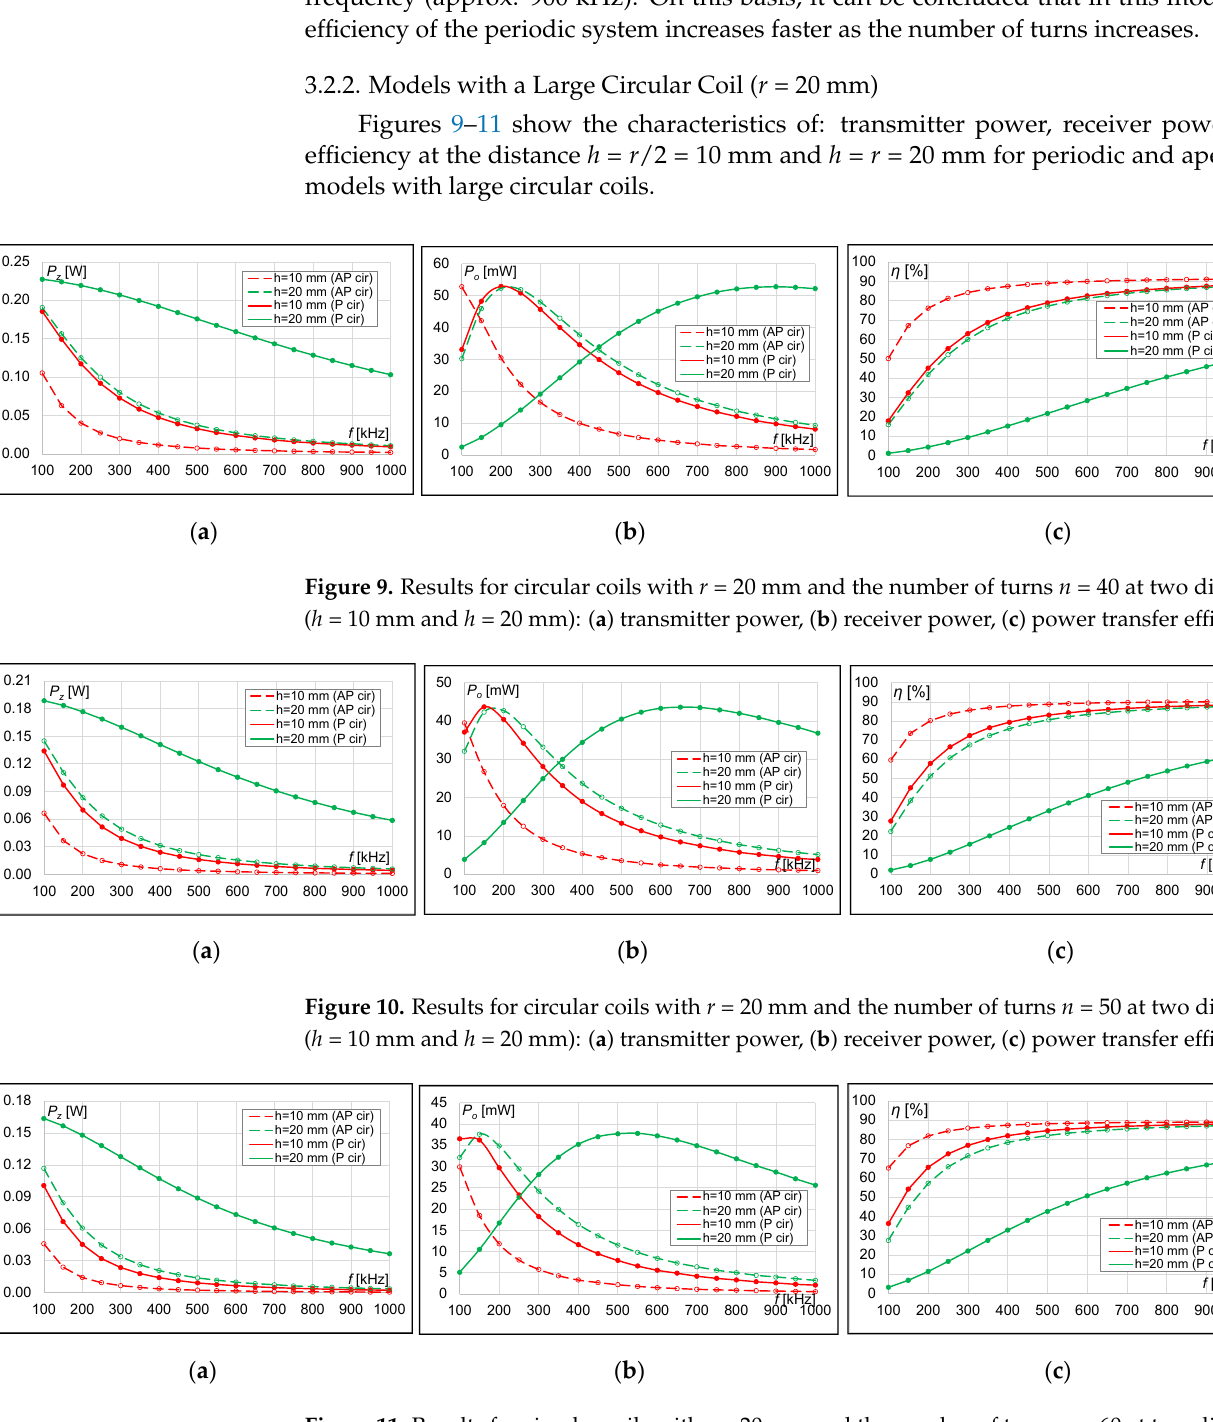
15 of 27 Figure 7. Results for circular coils with r = 5 mm and the number of turns n = 20 at two distances ( h = 2.5 mm and h = 5 mm): ( a ) transmitter power, ( b ) receiver power, ( c ) power transfer efficiency. ( a ) ( b ) ( c ) Figure 8. Results for circular coils with r = 5 mm and the number of turns n = 25 at two distances ( h = 2.5 mm and h = 5 mm): ( a ) transmitter power, ( b ) receiver power, ( c ) power transfer efficiency. In each of the analysed cases, the efficiency of the system increases with the increase in the number of turns (Figures 6c, 7c, and 8c). Regardless of the distance between the